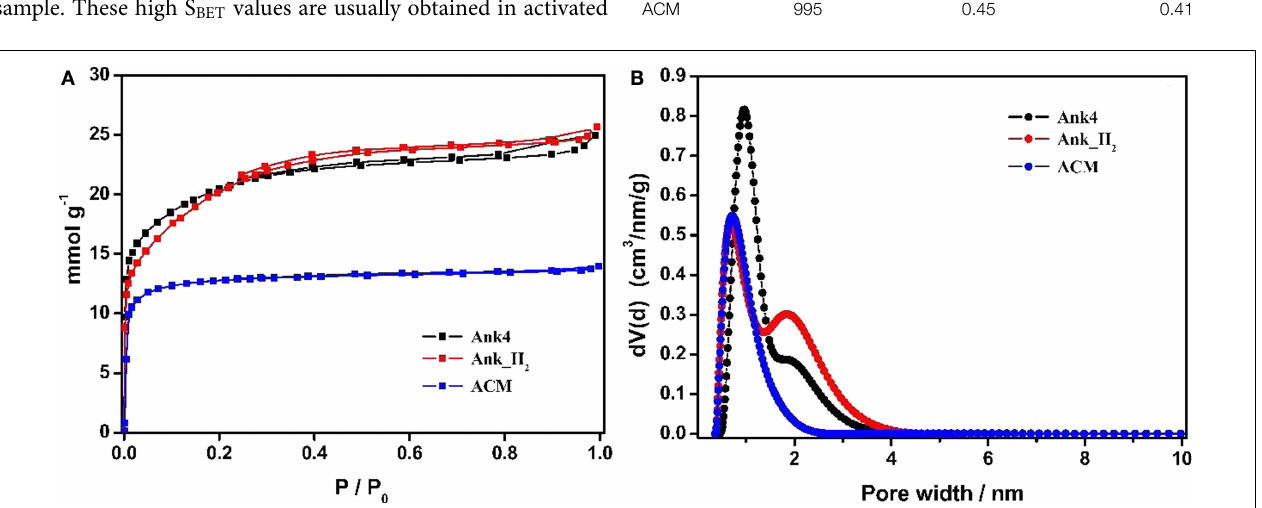
FIGURE 2 | (A) N 2 adsorption–desorption isotherms of the ACs samples. (B) N 2 adsorption NLDFT-PSD of ACs samples.